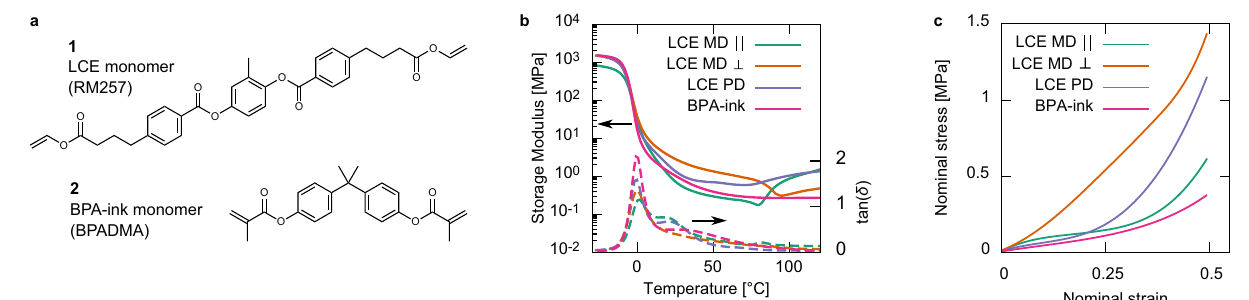
Fig. 2 Key chemical structures and basic mechanical characterization. a Chemical structures of the diacrylate monomer groups used in this work. RM257, 1 , has a stiff core which promotes liquid crystalline ordering. Bisphenol-A dimethacrylate (BPADMA, 2 ) does not have a rod-like core structure. b Dynamic mechanical analysis data comparing the storage moduli (solid) and loss ratio, tan( δ ), (dashed) properties of the key materials compared here. c Quasi- static (10 − 4 s − 1 displacement rate) compressive load curves of all materials compared here. Despite the key structural differences between the LCE MD k , LCE PD LCE BP-ink elastomer, they all have similar low-strain behavior meaning they can be